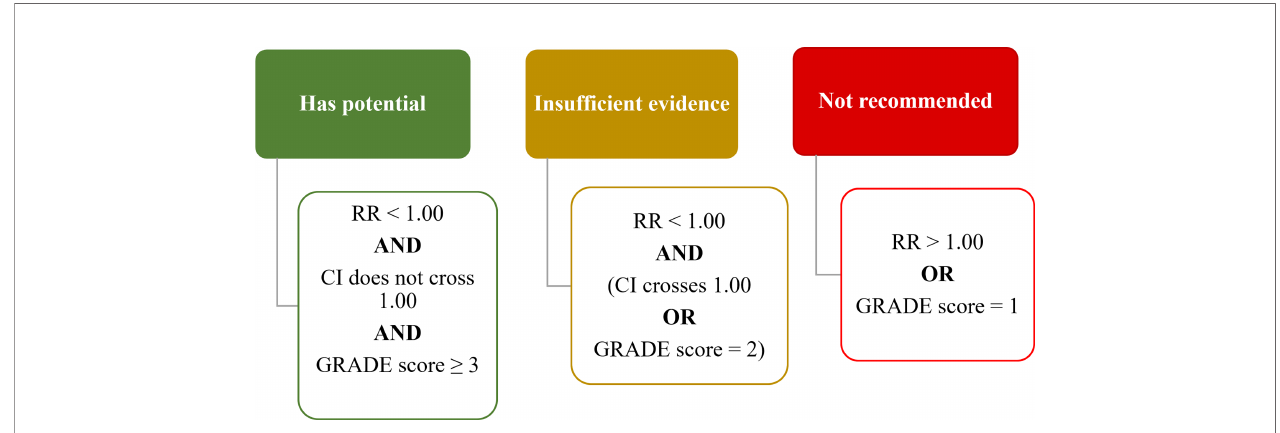
FIGURE 2 | Rating criteria on interventions to prevent OIPN. RR, risk ratio; CI, con fi dence interval. GRADE score ranges from High (4+), Moderate (3+), Low (2+) to Very Low (1+). (RR, Risk Ratio; CI, Con fi